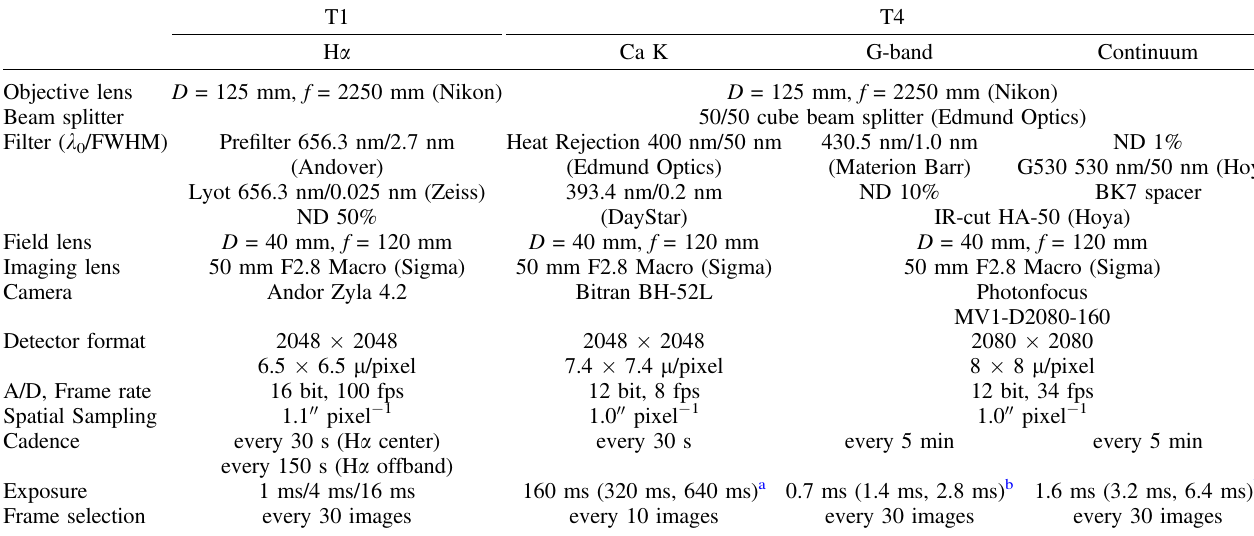
Table 1. Speci fi cations of imaging instruments installed in T1 and